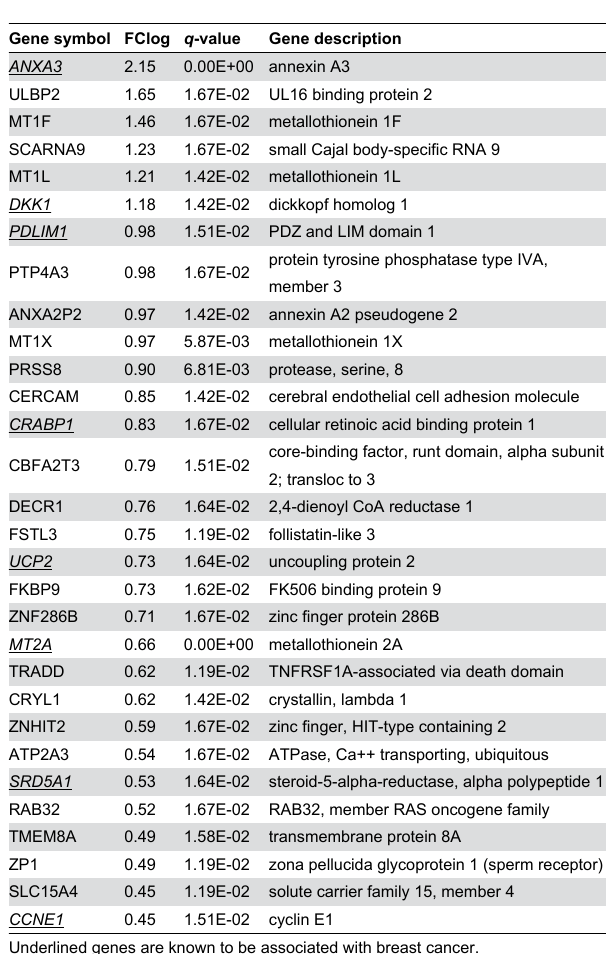
Table 2. 30 over-expressed genes with lowest q